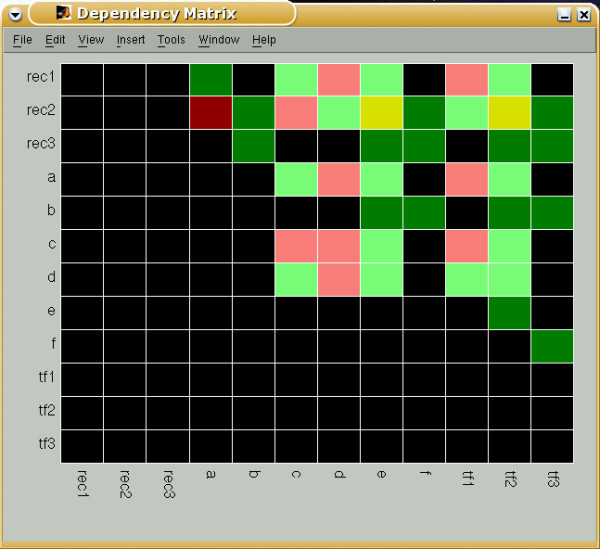
Dependency matrix of the network in Figure 2 as displayed by CellNetAnalyzer. The color of a matrix element Mxy has the following meaning (see [8] and text): (i) dark green: x is a strong (total) activator of y; (ii) light green: x is a weak (non-total) activator of y; (iii) dark red: x is a strong (total) inhibitor of y; (iv) light red: x is a weak (non-total) inhibitor of y; (v) yellow: x is an ambivalent factor for y; (vi) black: x does not influence y.